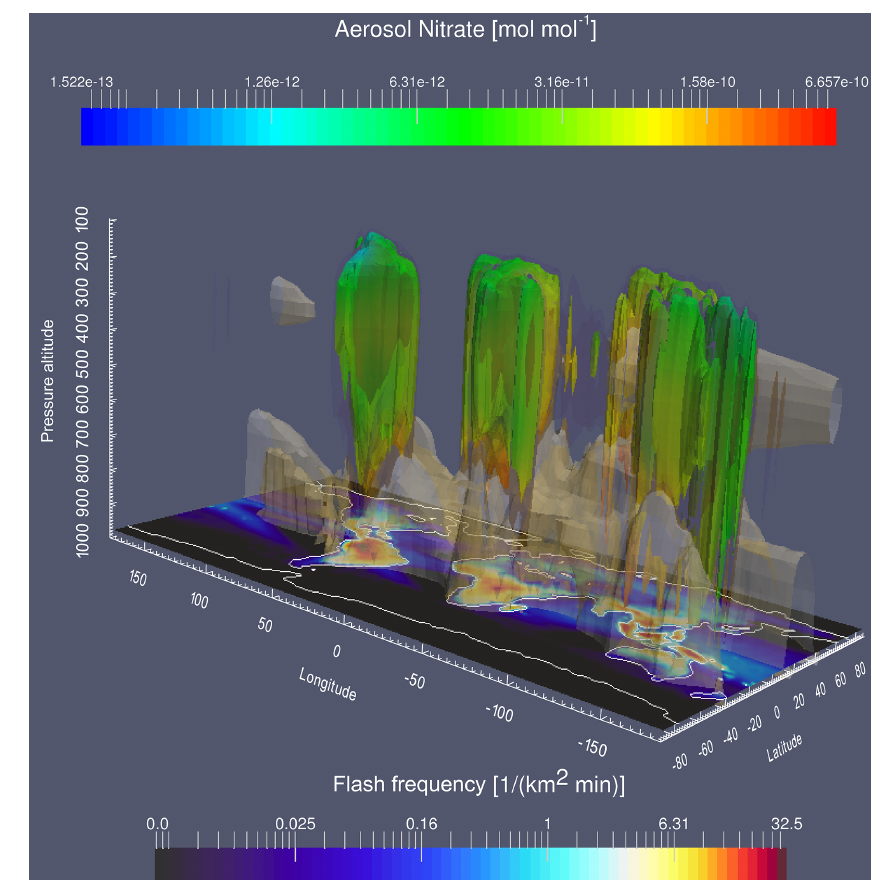
Figure 2. 3-D visualisation of LNO x emissions (coloured isosurface of 1 × 10 − 16 kg/(m 3 s) and darker-shaded isosurface of 3 × 10 − 16 kg/(m 3 s)) and the total aerosol nitrate mixing ratios (grey isosurface of 0.1ppb v ). Additionally, the mean flash rate in 1/(km 2 min) is depicted by the 2-D slice at the bottom. Note the logarithmic scaling of both colour